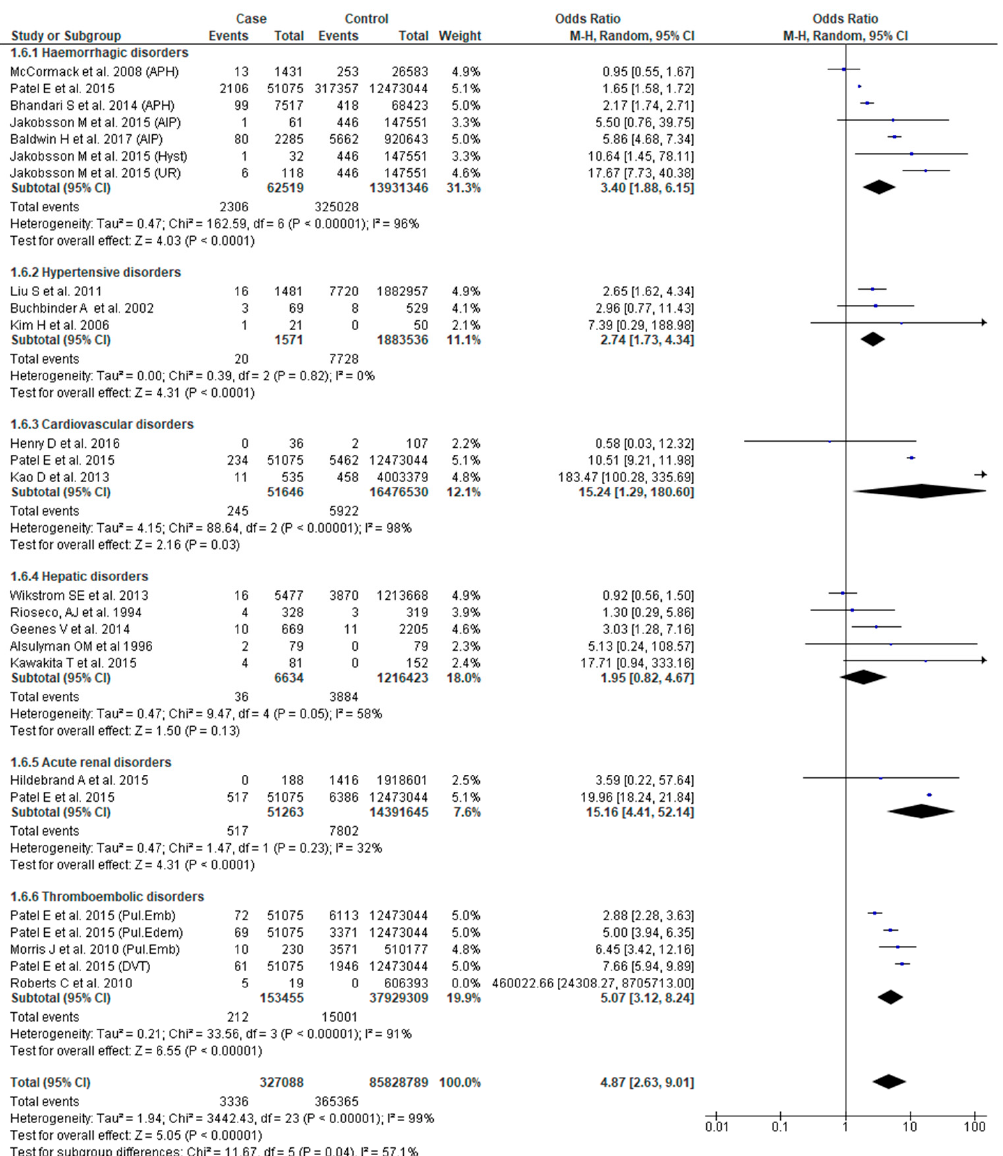
Figure 7. Forest plot of studies assessing association between Severe maternal morbidity (SMM) and stillbirth